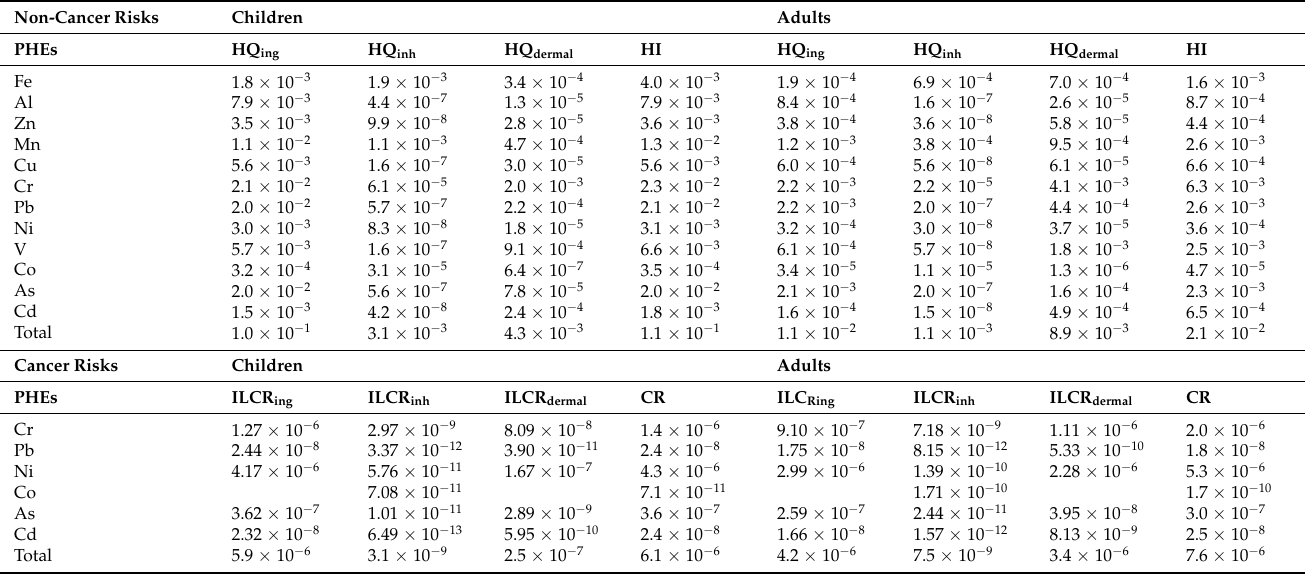
Table 3. Summary of hazard quotients (HQ), hazard index (HI), incremental lifetime cancer risk (ILCR), and cancer risk (CR) of PHEs in ACFD collected samples from Jubail mosques via non-dietary ingestion, inhalation, and dermal contact exposure pathways.